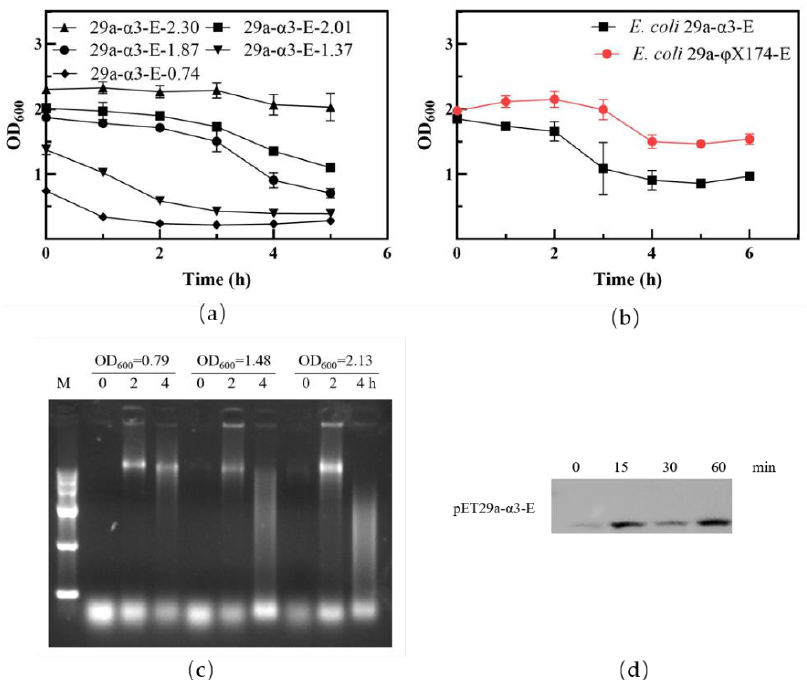
Figure 1. Effect of lysis protein E in bacteria. ( a ) Lysis curve of E. coli BL21(DE3) containing the pET29a- α 3-E plasmid at different induction starting points. ( b ) Comparative analysis of lysis function in E. coli BL21(DE3) containing different lysis plasmids. ( c ) Electrophoretic analysis of genetic material in the supernatant of E. coli BL21(DE3) cultures before and after lysis. ( d ) Western blot of lysis protein E from phage α 3.